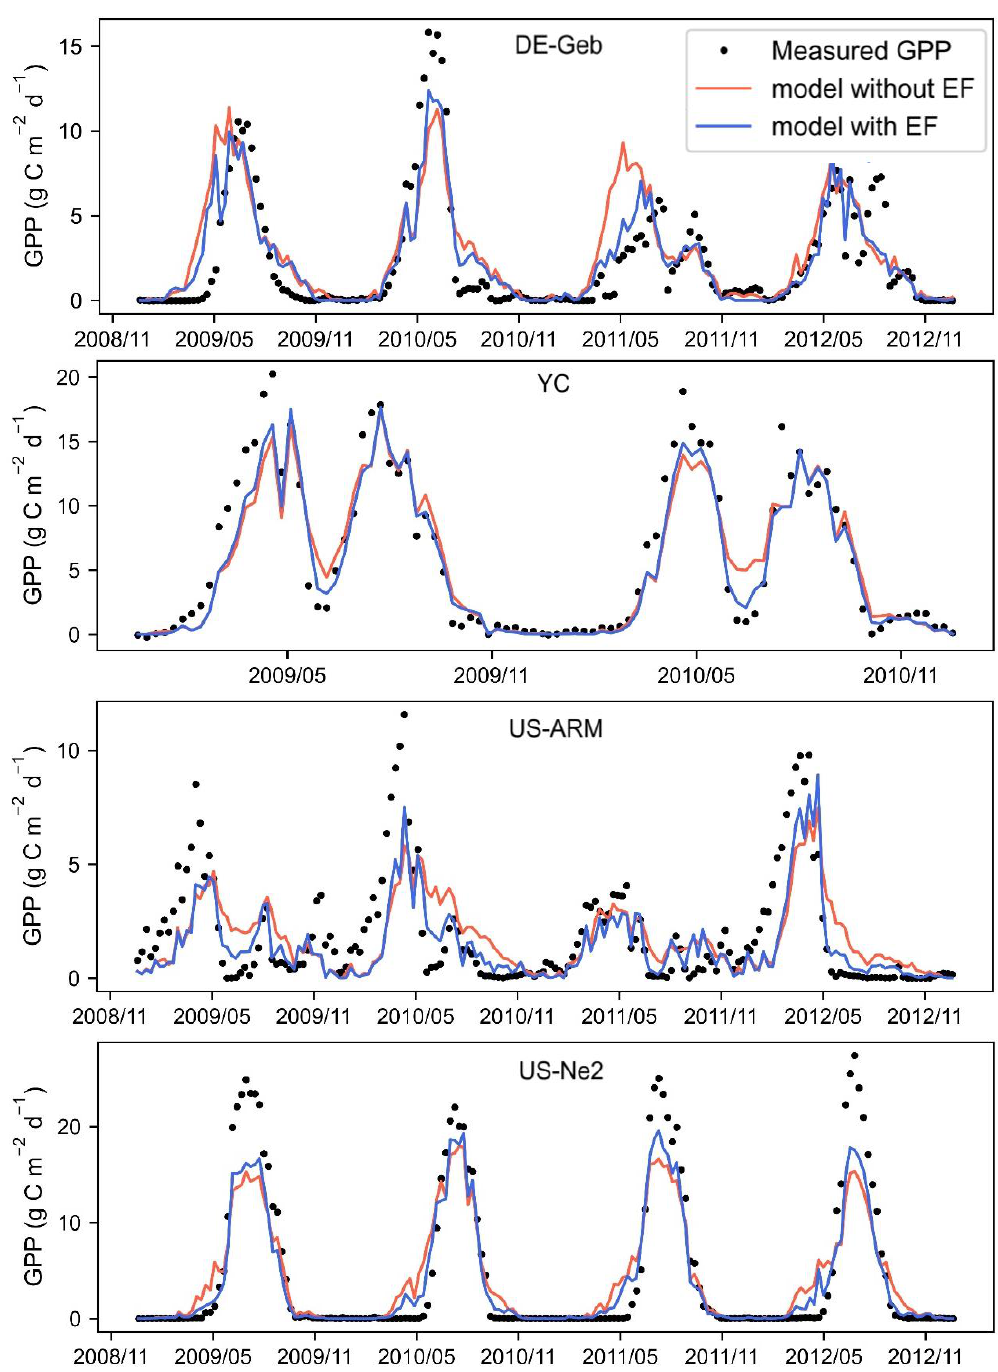
Figure 5. Comparisons of 8-day mean GPP between the EF-LUE model and the model without EF against the ground measurements at four cropland flux tower sites. Black solid dots indicate the GPP measurements by eddy covariance system. The blue line and red line represent the GPP estimated by the EF-LUE model and the model without EF, respectively.